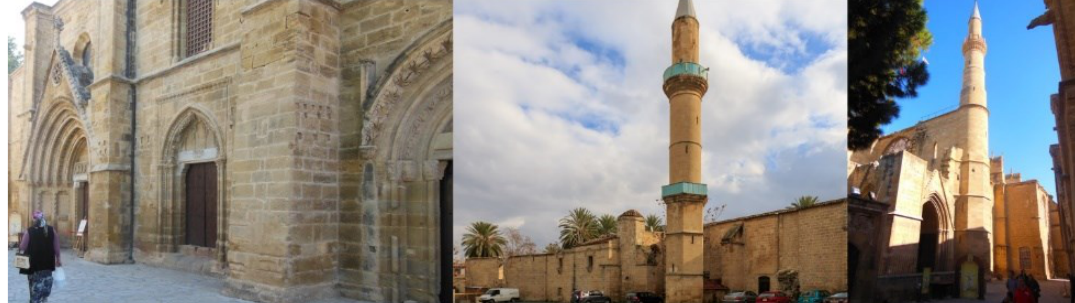
Figure 1. Bedesten as an exhibition hall in Lefkosa (left), Omeriye mosque in Nicosia (centre and Agya Sophia in Lefkosa 3.1 States’ roles over the respective heritages: post-trauma